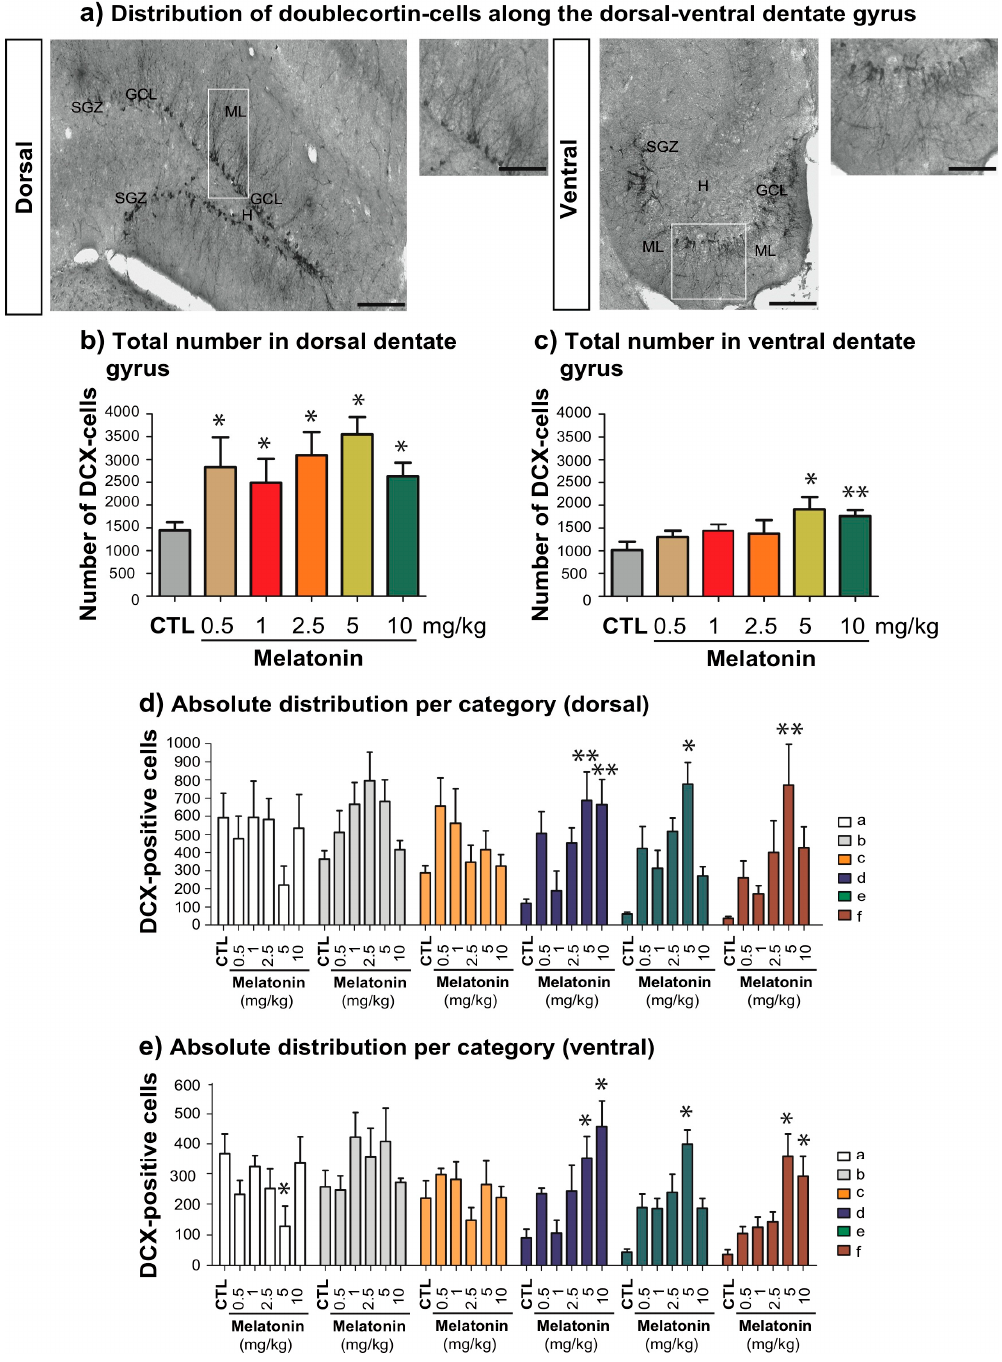
Figure 3. Distribution of doublecortin-cells along the dorsal-ventral dentate gyrus of adult male Balb/C mice. Mice were intraperitoneally injected either with 0.5, 1, 2.5, 5 and 10 mg/kg of melatonin or vehicle for 14 days. Coronal and transversal sections within the dorsal or ventral dentate gyrus are shown in ( a ). Representative pictures show the subgranular zone delimited by DCX-associated cells (SGZ).